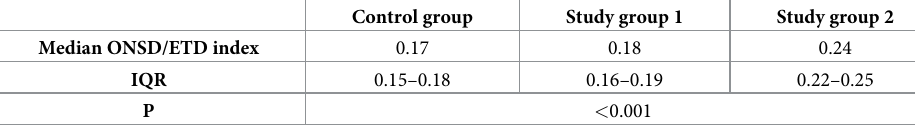
Table 2. Median and IQR values of ONSD/ETD index according to clinical